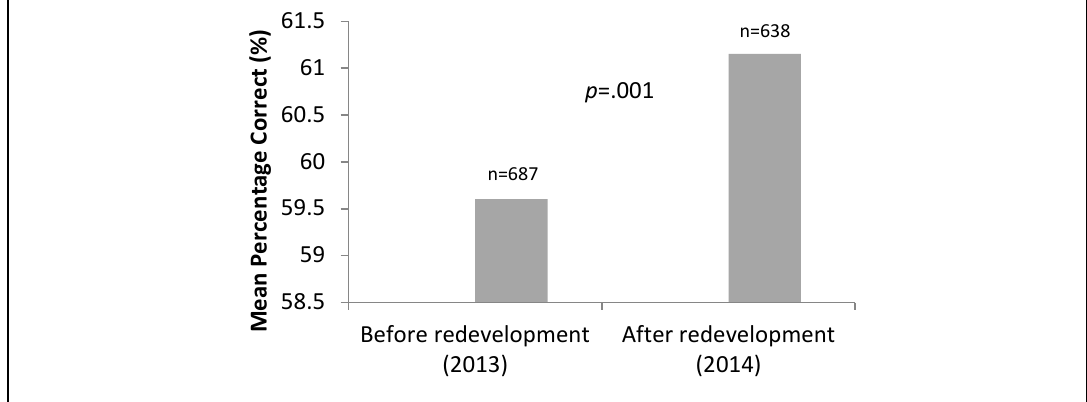
Figure 1: Exam questions analysed for semester 1 before and after the laboratory redevelopment.